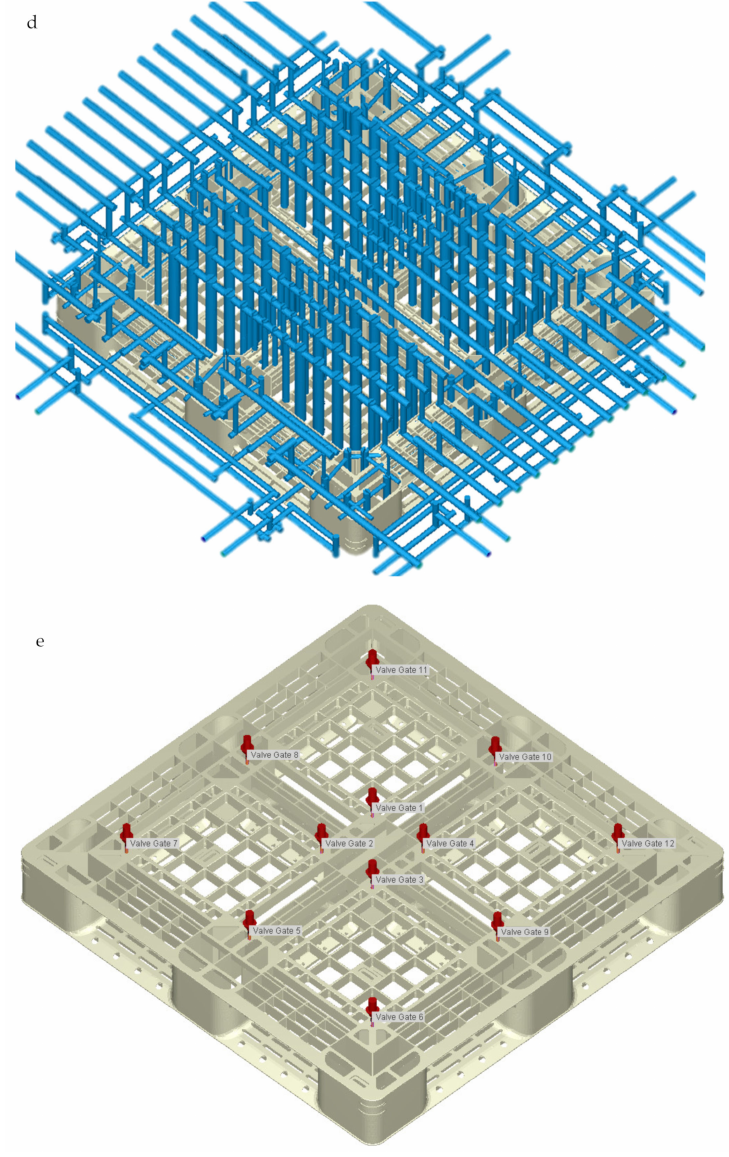
Figure 1. Injection-molded pallet (1100 mm × 1100 mm × 140 mm): ( a ) isometric view of the pallet (top side); ( b ) isometric view of the pallet (bottom side); ( c ) isometric view of the baffle cooling flow system on the top side of the pallet; ( d ) isometric view of the baffle cooling flow system on the bottom side of the pallet; ( e ) 12 filling gates in the